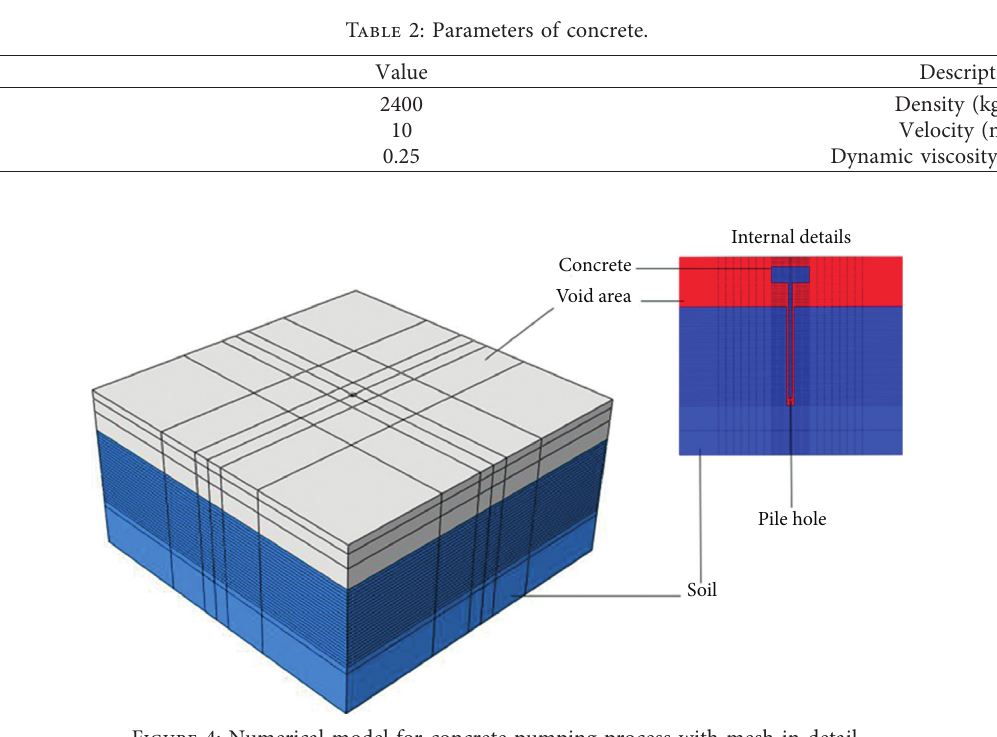
Figure 4: Numerical model for concrete pumping process with mesh in detail.